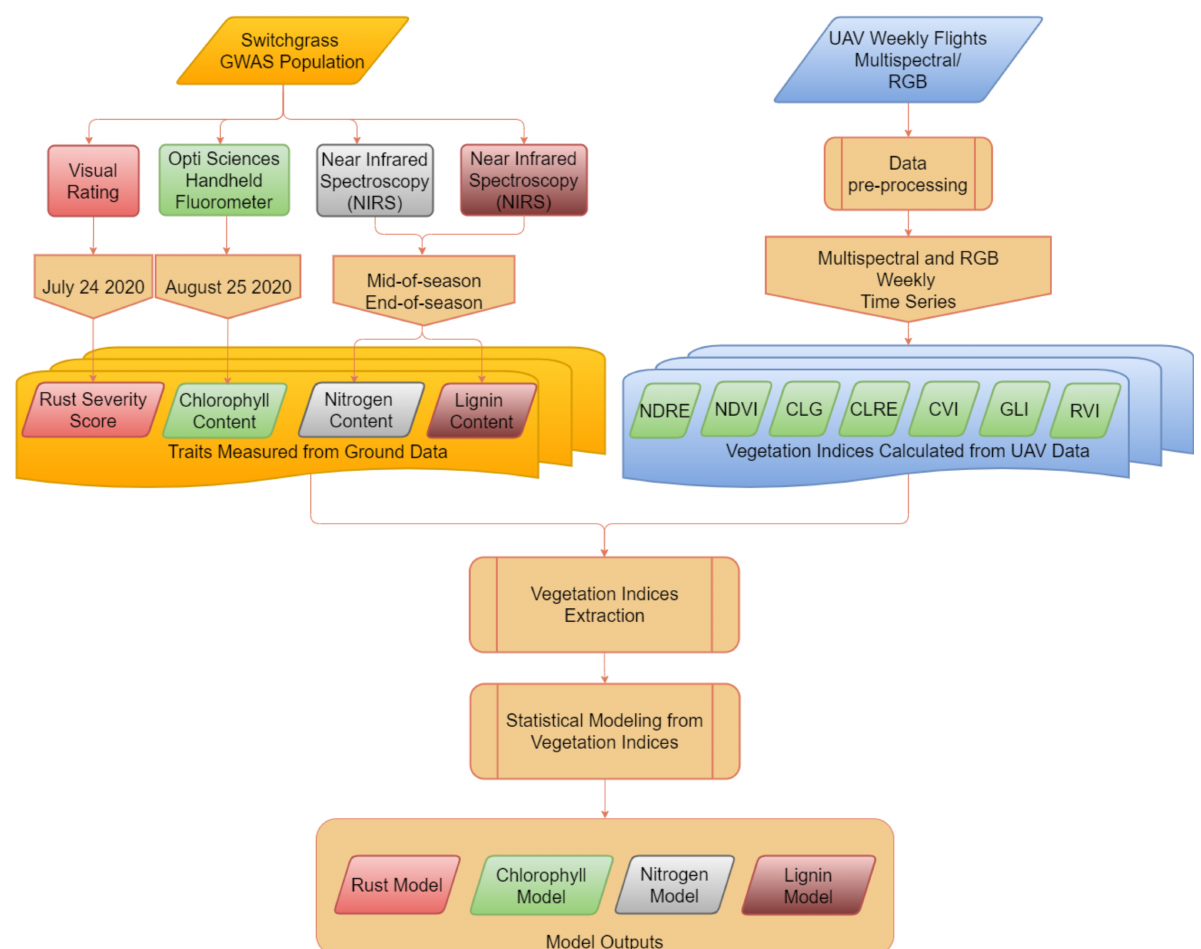
Figure 5. Data processing and analysis pipeline for switchgrass sustainability traits